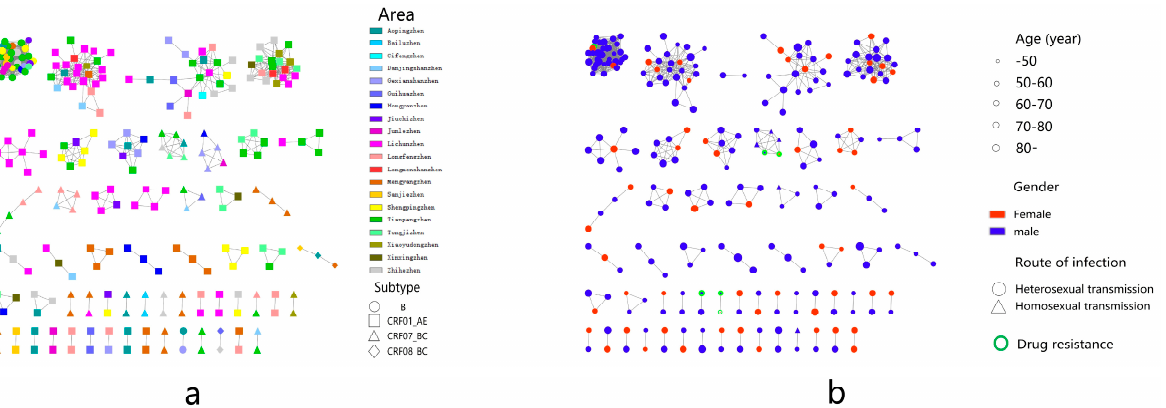
Figure 2. Molecular network diagram. ( a ) Township and subtype virus molecular transmission network. ( b ) Age, sex, transmission route and drug resistance in the molecular transmission network.